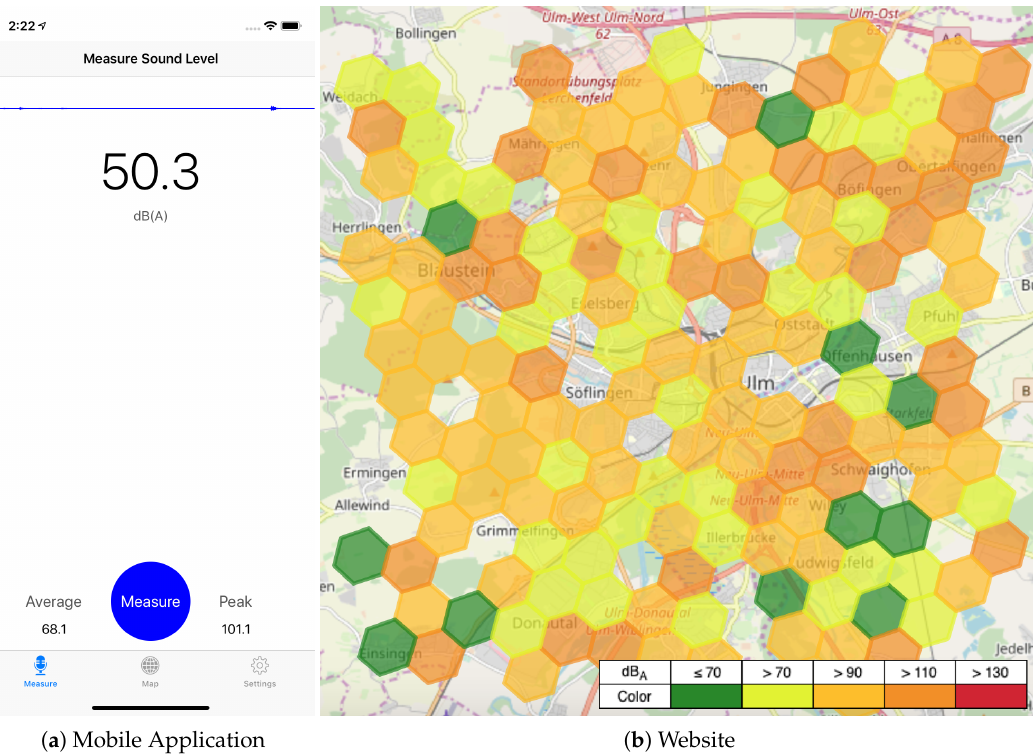
Figure 10. Screenshots of the mobile application and the website showing the noise level map. Reproduced with permission from Kraft et al., In Proceedings of the 2019 IEEE 32nd International Symposium on Computer-Based Medical Systems (CBMS); published by IEEE, 2019